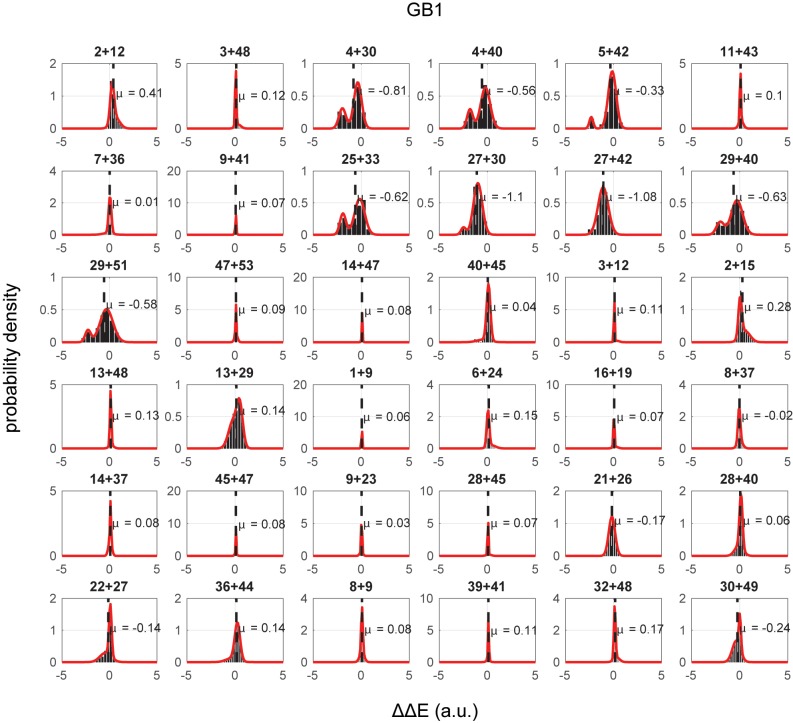
Distributions of coupling in relative enrichment (ΔΔE) for a sampling of position pairs in the GB1 domain of the immunoglobulin-binding protein G.The data are from (Olson et al., 2014), and position numbering is as given in that work; note that coupling is calculated here directly from enrichment scores. As in Figures 1 and 2, distributions are fit to single or double Gaussians, using the Bayes Information Criterion to choose the model. The population weighted mean is represented in dashed lines, and values for each position pair are shown. Note that coupling energies are reported with the opposite sign due to the inverse relationship between ∆E in Olsen et al. and ΔG in this work.